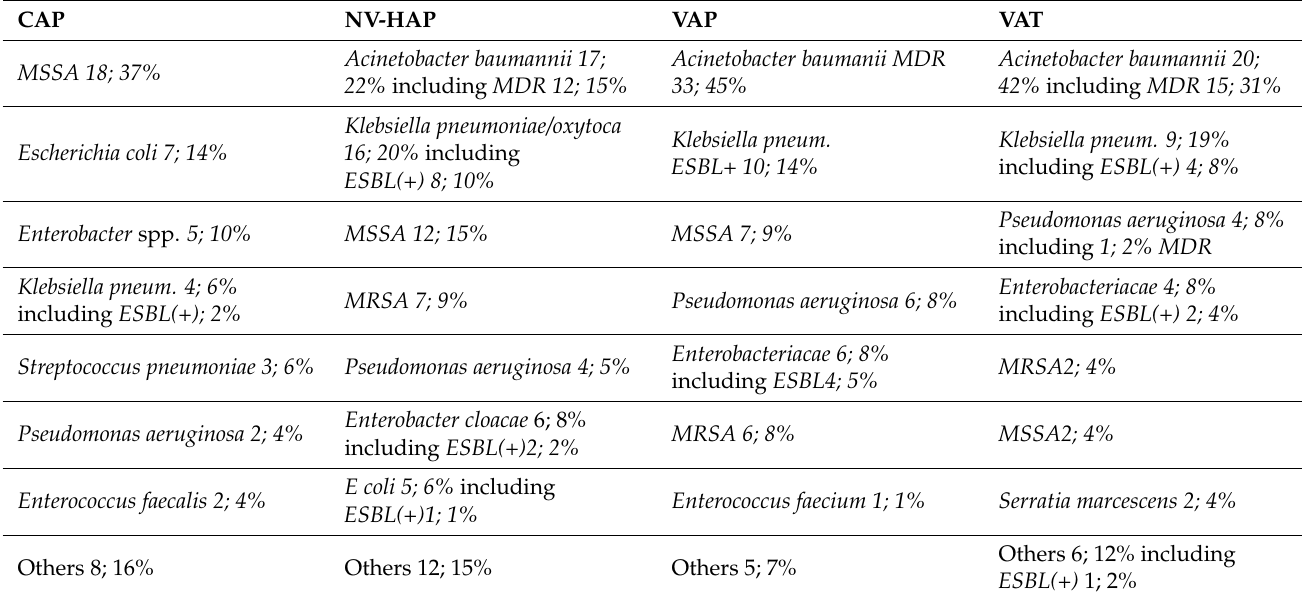
Table 4. Pathogens of respiratory tract infections. Data was shown as number of pathogens and % from total number of strain responsible for CAP ( n = 49), NV-HAP ( n = 79), VAP ( n = 74) or VAT ( n =